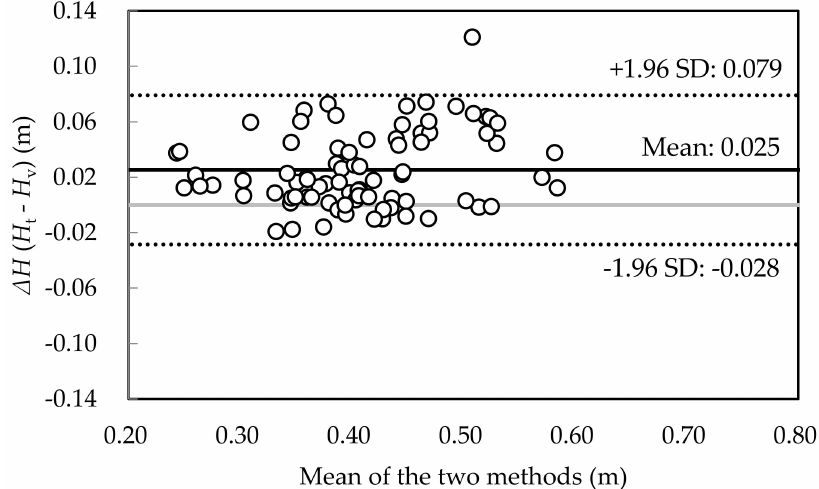
Figure 3. Bland–Altman plot for the jump height from the vertical velocity at takeo ff ( H v ) and the jump height from flight time (H t ). The central line represents the absolute average di ff erence between the methods, and the upper and the lower lines represent ± 1.96 standard deviation